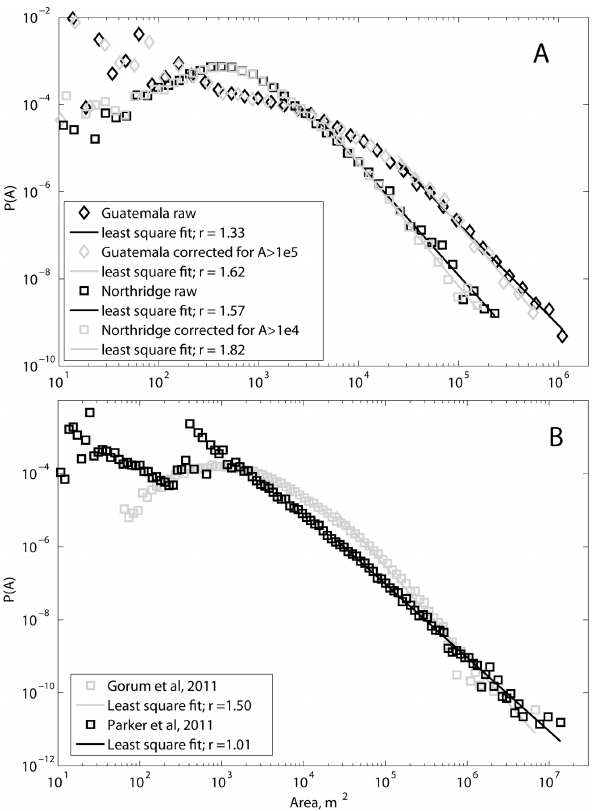
Figure 3. Amalgamation effect on landslide area–frequency distri- butions. (a) Comparison between the raw data from the coseismic landslide maps for the 1976 Guatemala and 1994 Northridge earth- quakes and the corrected catalogue where every amalgam larger than 100000 and 10000m 2 was split, respectively. (b) For the 2008 Sichuan earthquake, several landslide maps were published. Of these, the Parker et al. (2011) data set is severely affected by amalgamation whereas the Gorum et al. (2011) data set is relatively exempt from